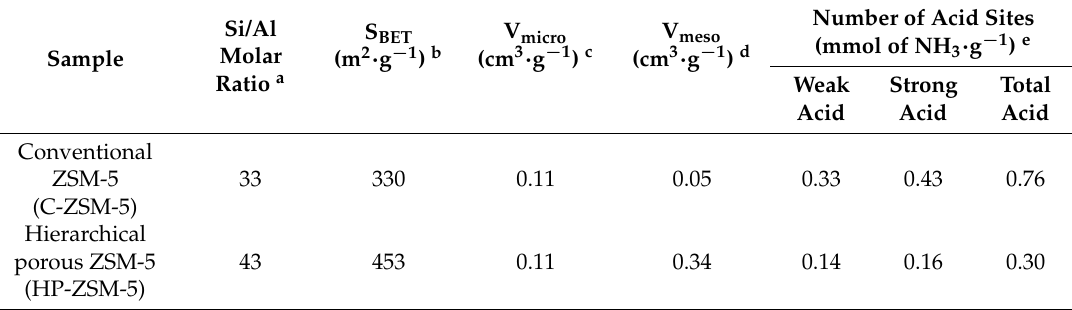
Table 1. The physico-chemical properties of the